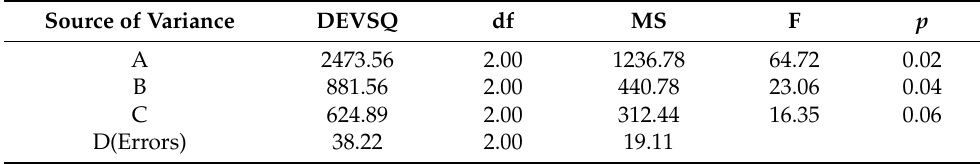
Table 3. Results of variance analysis of orthogonal design. Source of Variance